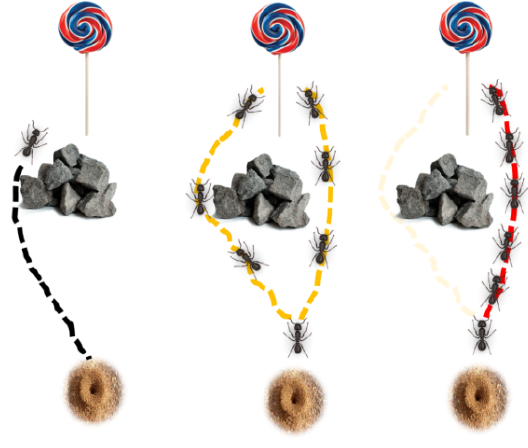
Figure 4: Basic concept of Ant colony optimization